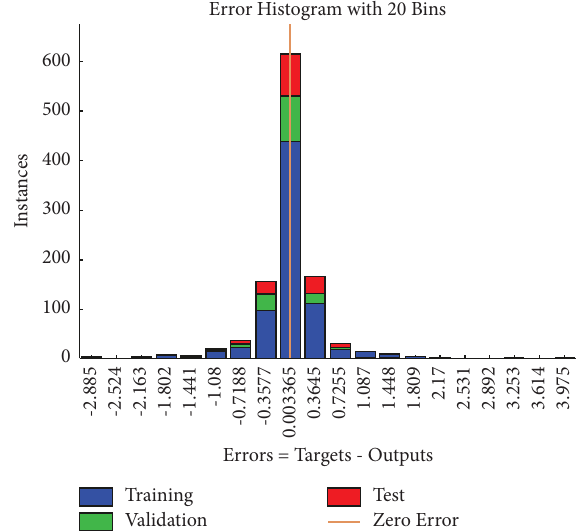
Figure 3: Te error histogram for the backpropagation Levenberg- Marquardt training of the data.